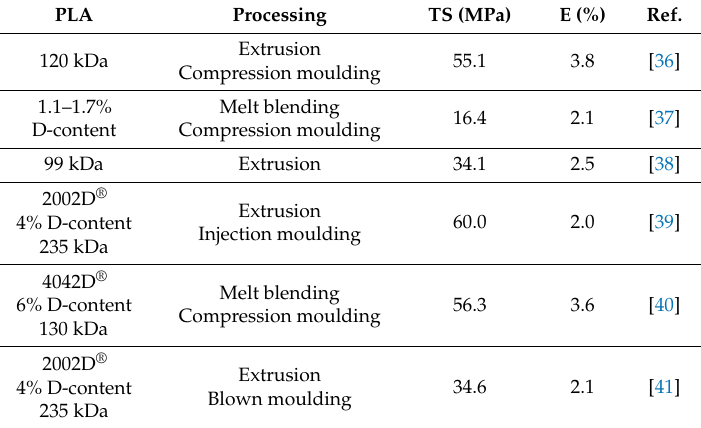
Table 1. Tensile properties of neat PLA films reported by different authors. Tensile strength (MPa) and Elongation at break